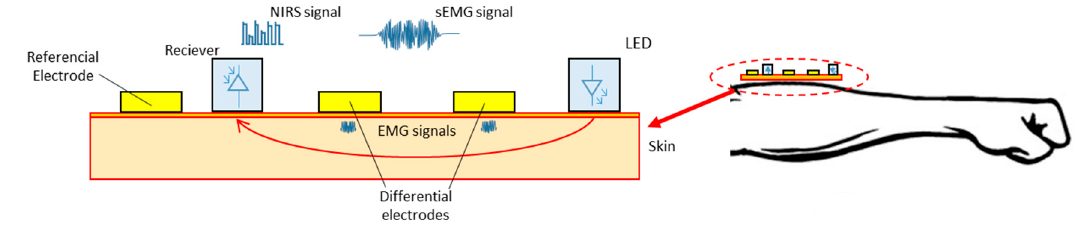
Figure 10. Fusion system of signals from NIRS (Near-Infrared Spectroscopy) and EMG (Electromyography).